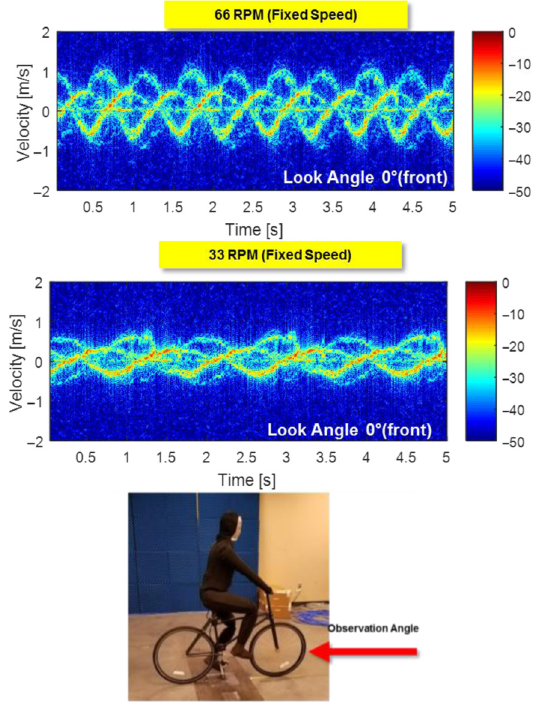
Figure 20 Micro-Doppler response of pedaling legs with stationary wheels of the surrogate bicycle